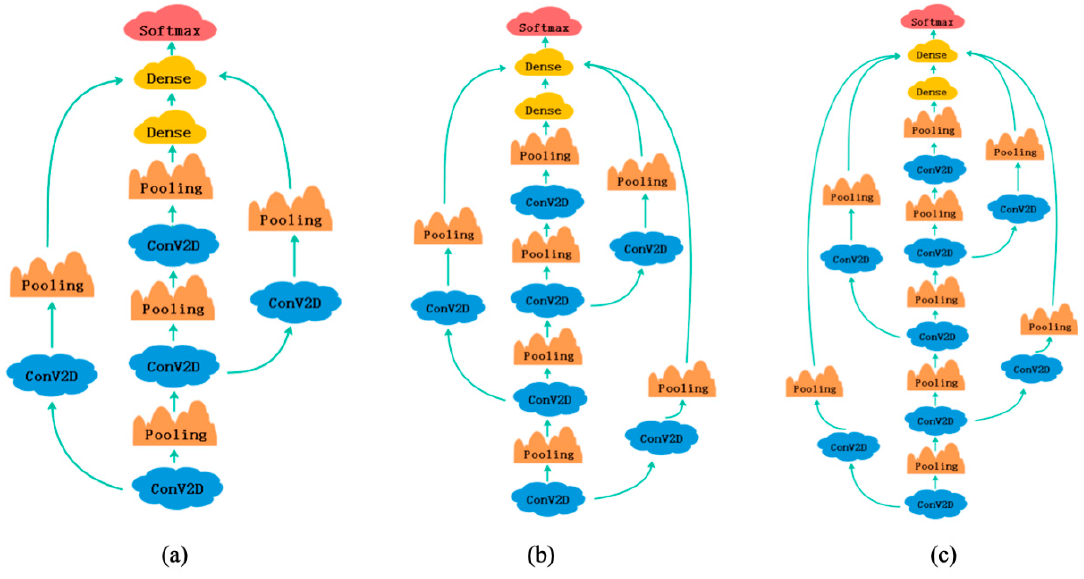
Figure 7. Experiments using C-c CNN models with different numbers of layers: ( a ) basic C-c CNN, ( b ) C-c CNN with one added layer, and ( c ) C-c CNN with two added layers.